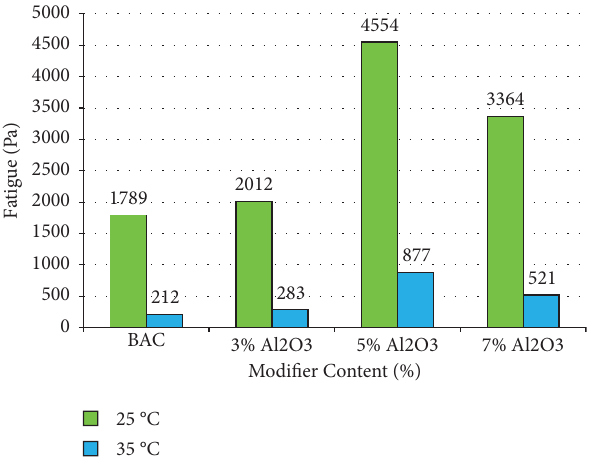
Figure 8: Te efects of fatigue on base and modifed binders.